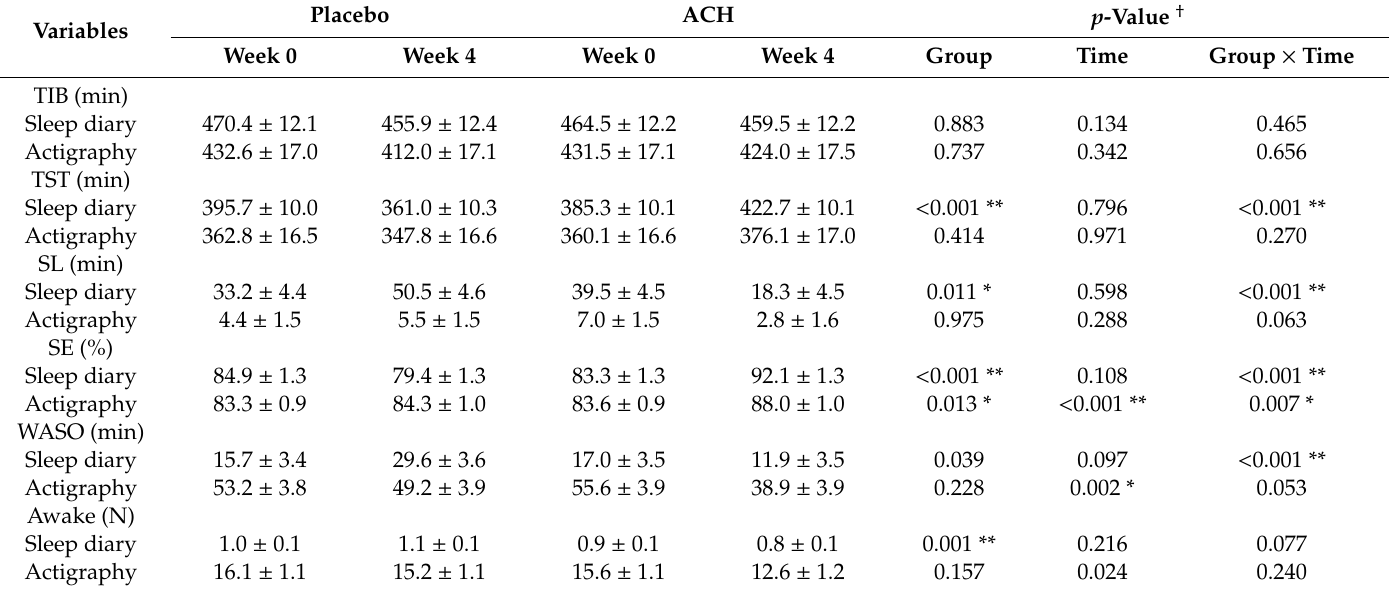
Table 3. Comparison of sleep parameters between control (placebo) and test (ACH)